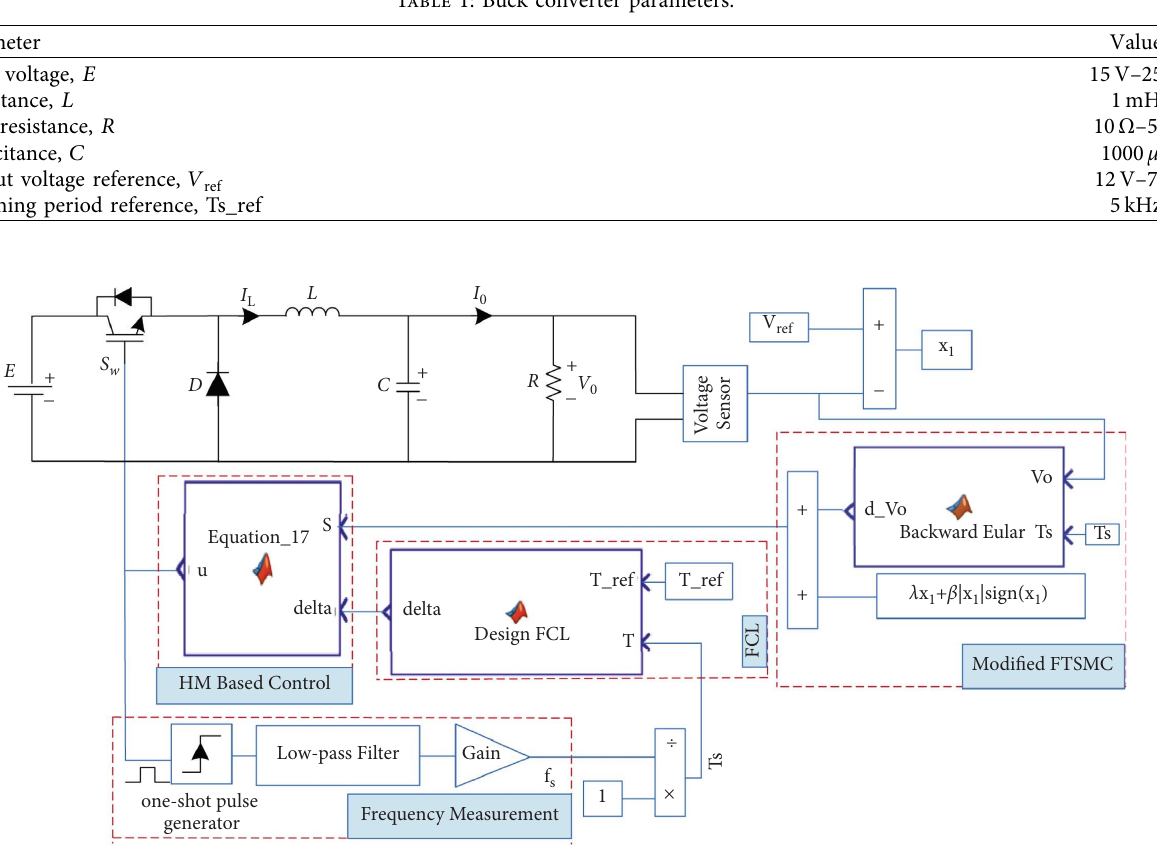
Figure 9: Block diagram of the buck converter with controllers.